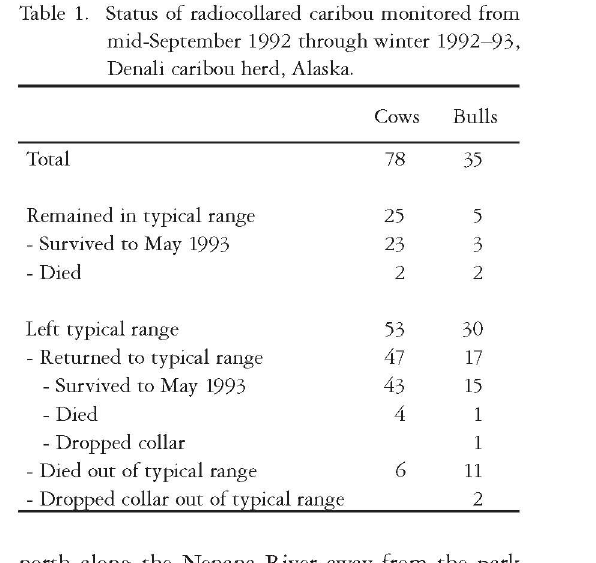
Table 1. Status of radiocollared caribou monitored from